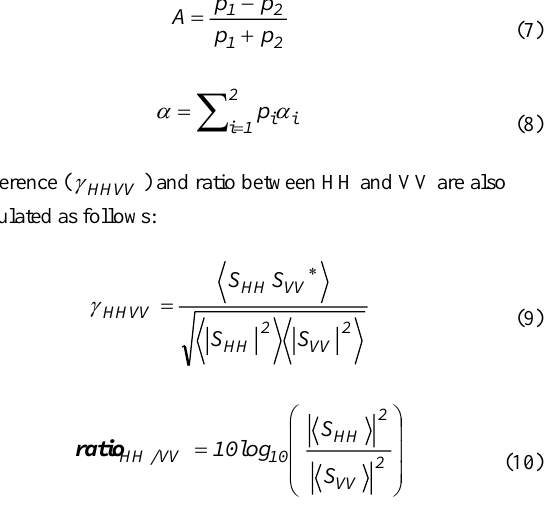
Figure 1: An example of a TSX amplitude image of July 26 th 2012 over google earth image in Doroud and the subset area shown with RGB colour composite in Pauli basis over the agricultural